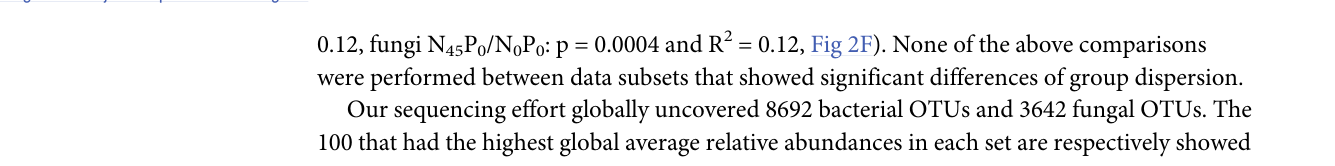
were performed between data subsets that showed significant differences of group dispersion. Our sequencing effort globally uncovered 8692 bacterial OTUs and 3642 fungal OTUs. The 100 that had the highest global average relative abundances in each set are respectively showed